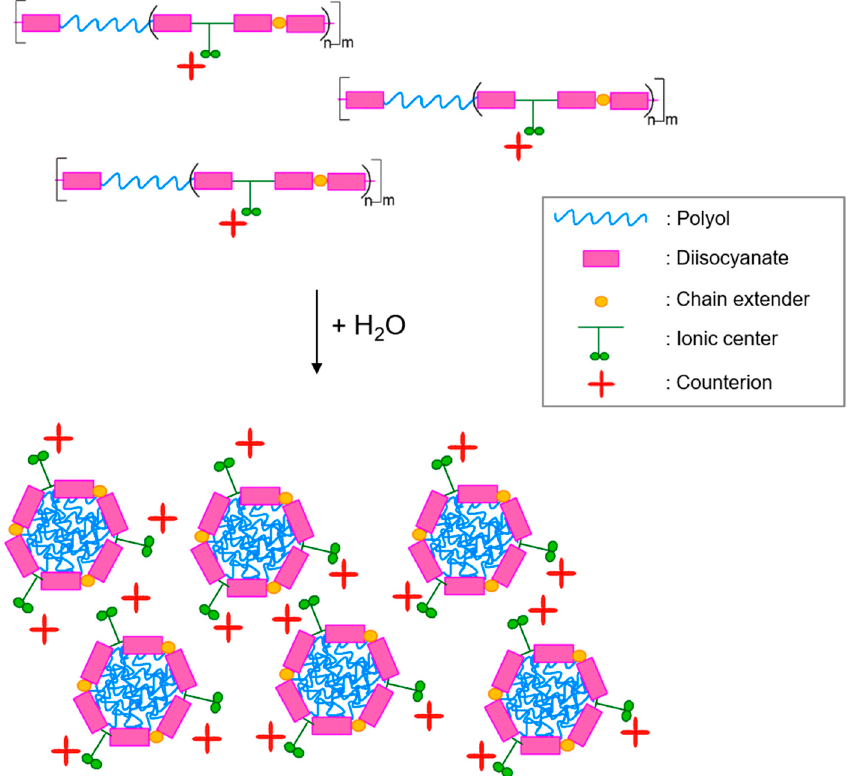
Figure 3. Scheme of particle’s formation in ionic WBPU or WBPUU dispersions.